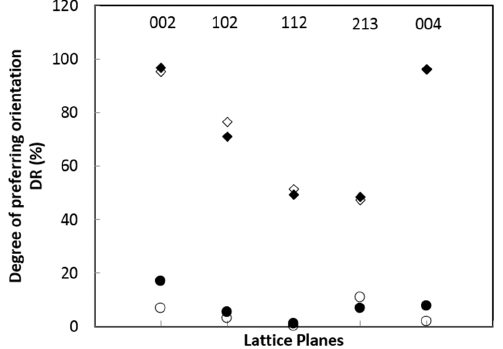
Figure 4. Relationship between lattice planes and index DR. Empty square: fishbone, black square: 161212, empty circle: powder, black circle: fried-powder.